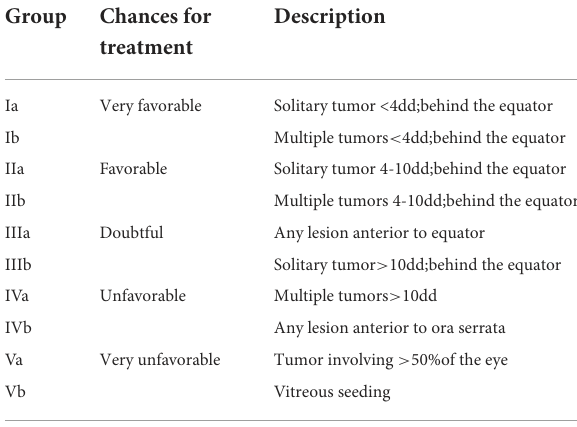
TABLE 1 Classification of retinoblastoma